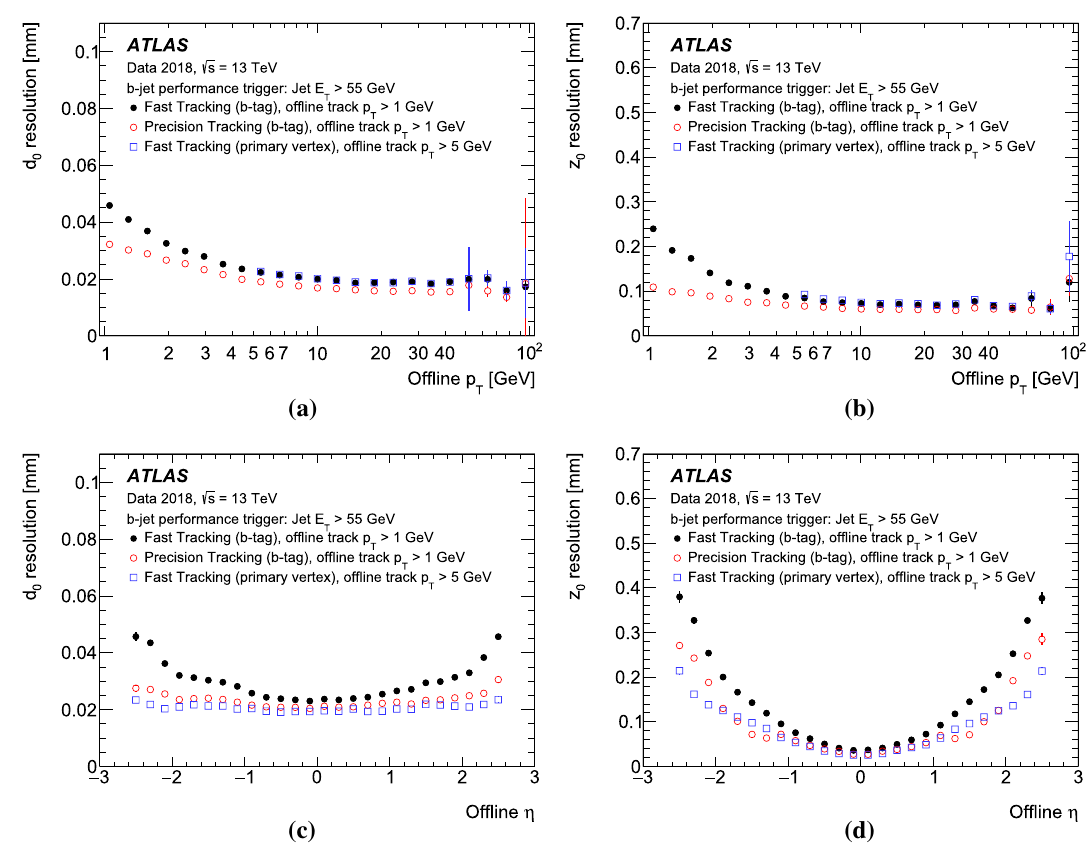
Fig. 6 The d 0 resolution (left) and z 0 resolution (right) of the tracking algorithms used by the b -jet trigger with respect to the offline mea- surement, as a function of offline track p T (top) and η (bottom), for